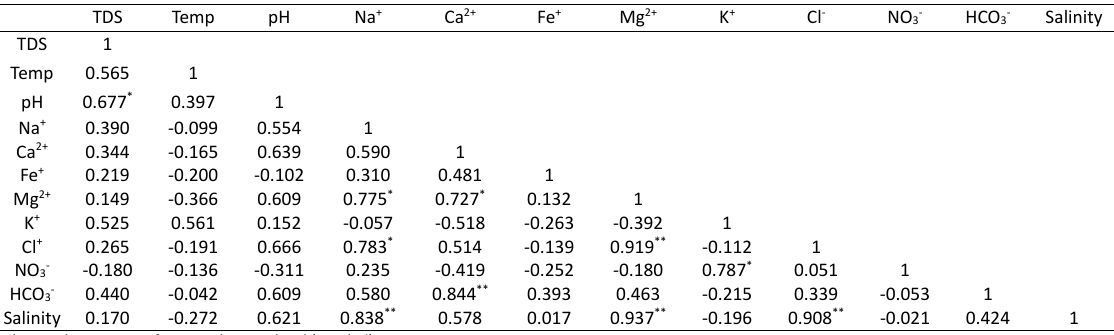
Table 4: Pearson correlation coefficients for 10 variables of water samples in wet season TDS Temp pH Na +